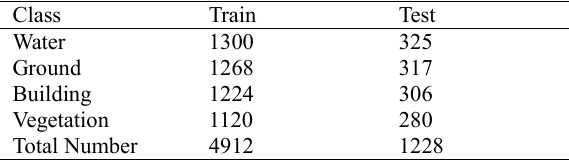
Figure 5. Coastline extraction flow chart